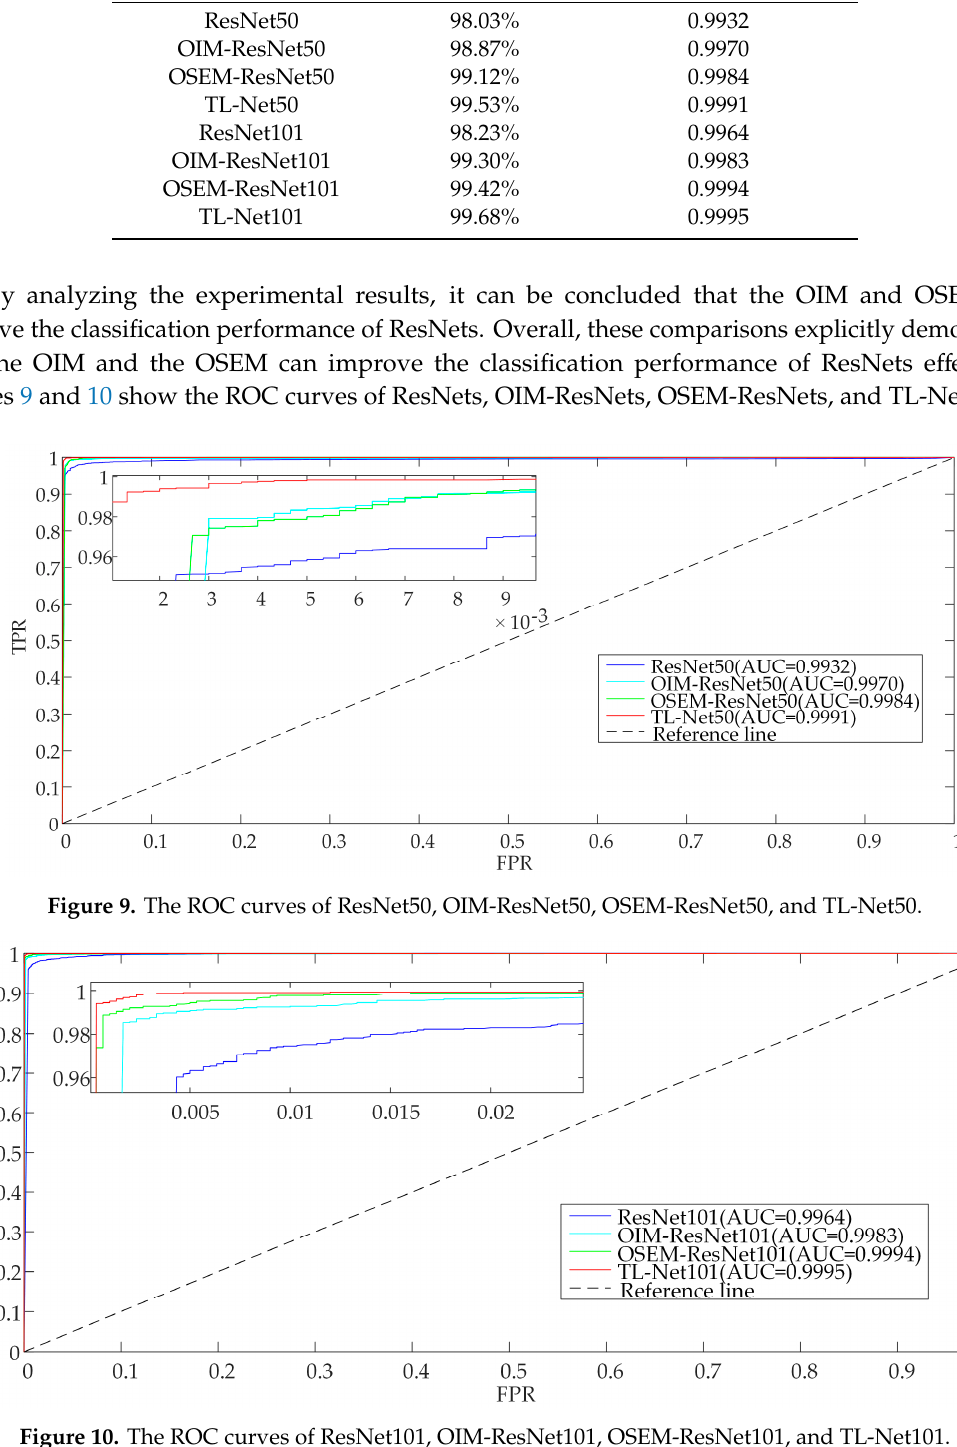
( b ) Figure 11. ( a ) The training accuracy curves of ResNet50 and TL-Net50; ( b ) the training loss curves of ResNet50 and TL-Net50.